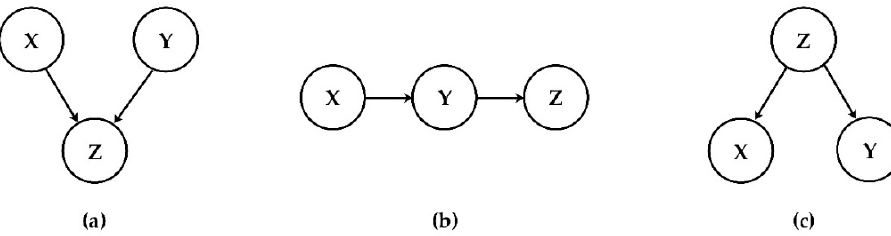
Figure 2. ( a ) Directed acyclic graphs for Bayesian network; ( b ) simple Bayesian network model.